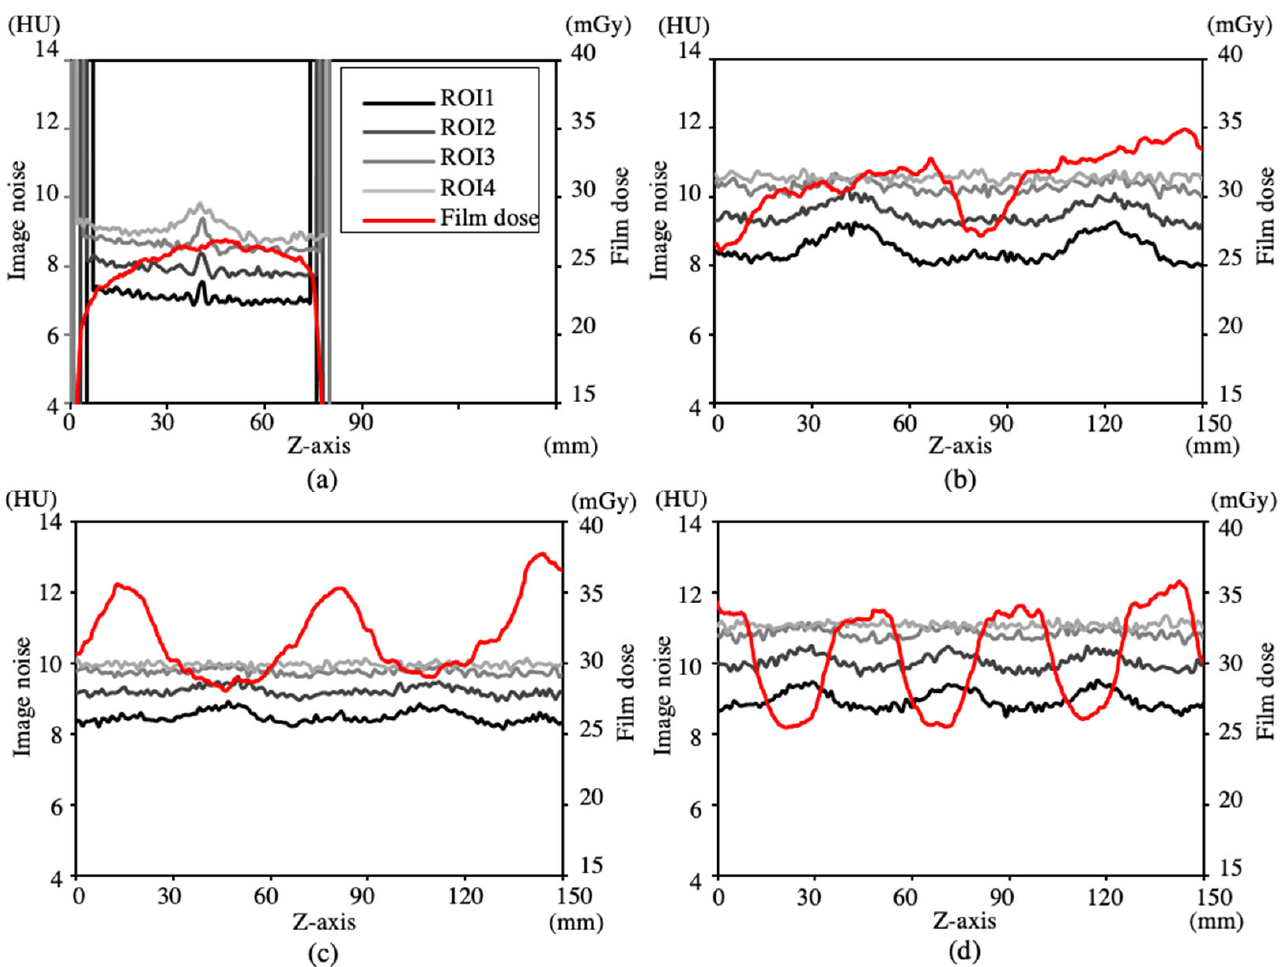
Table A1. ROI2, ROI3, and ROI4 in 256-slice CT for one axial and three helical scans with pitch values of 0.992, 0.696, and 0.399.